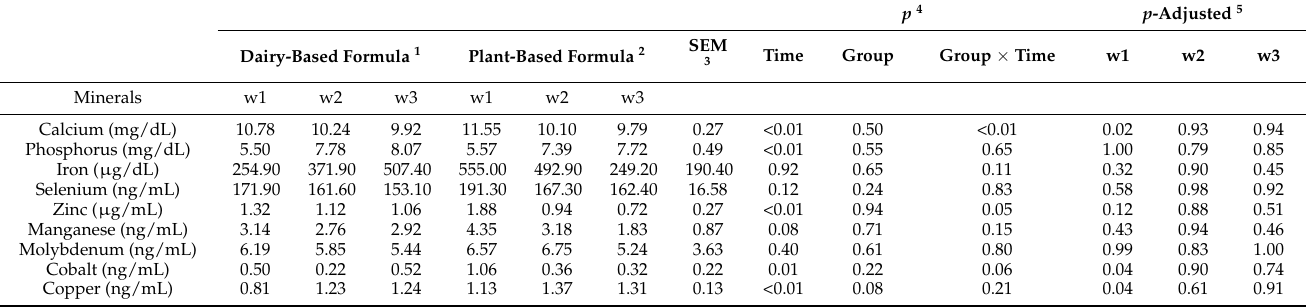
Table 5. Concentration of minerals (group average) per week of age (w1, w2, w3) in the plasma of piglets fed either a dairy-based or a plant-based formula ( n = 9/group) from postnatal day (PND) 2 until PND 21.